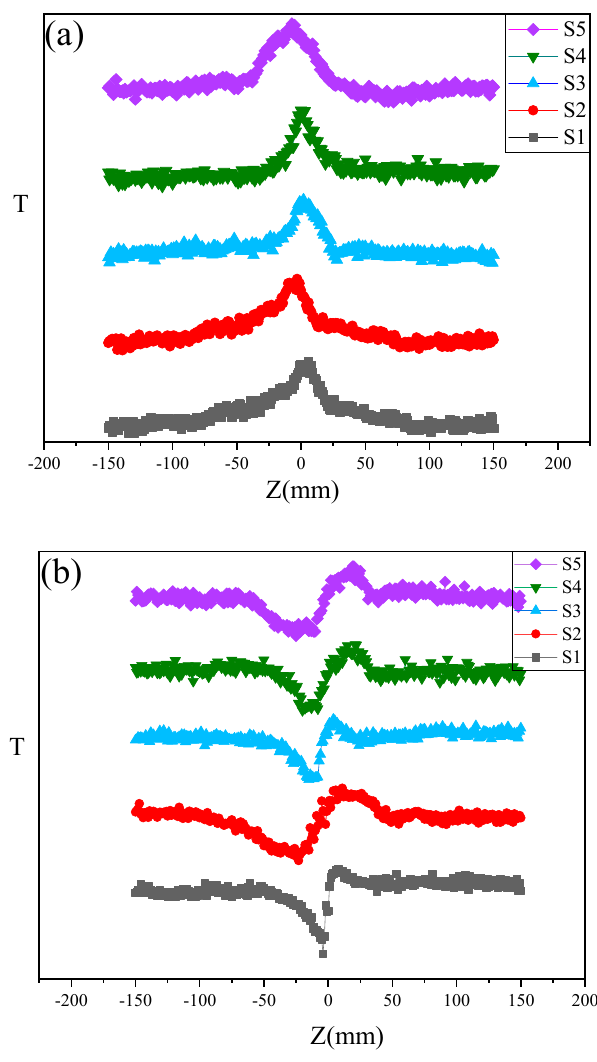
Figure 10. ( a ) OA Z-scan curves and ( b ) CA/OA of Z-scan curves S1, S2, S3, S4 and S5.